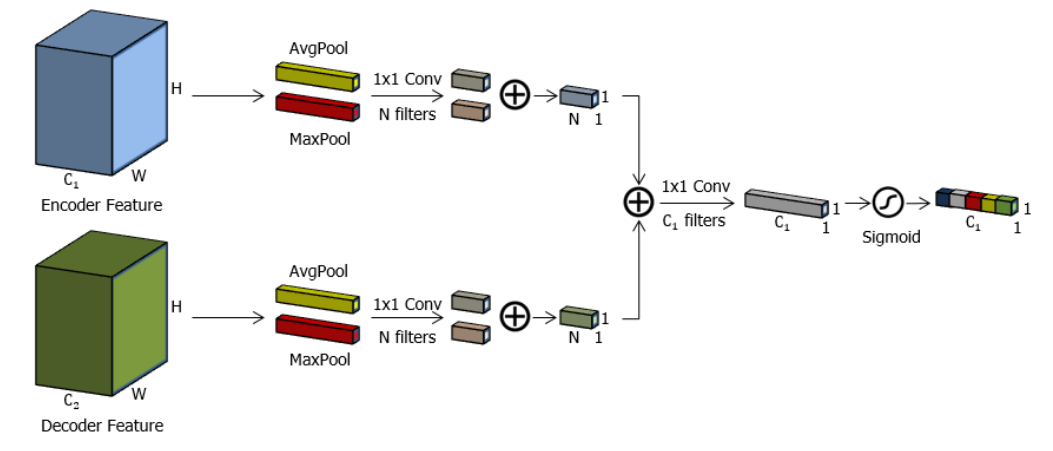
Figure 3. Diagram of the Channel Attention Gate